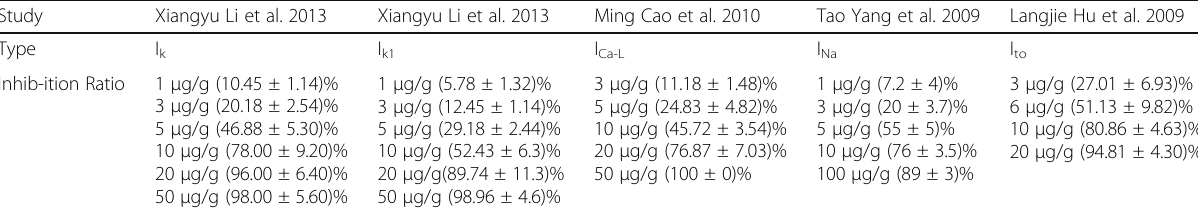
Table 3 The information of dose-response Study